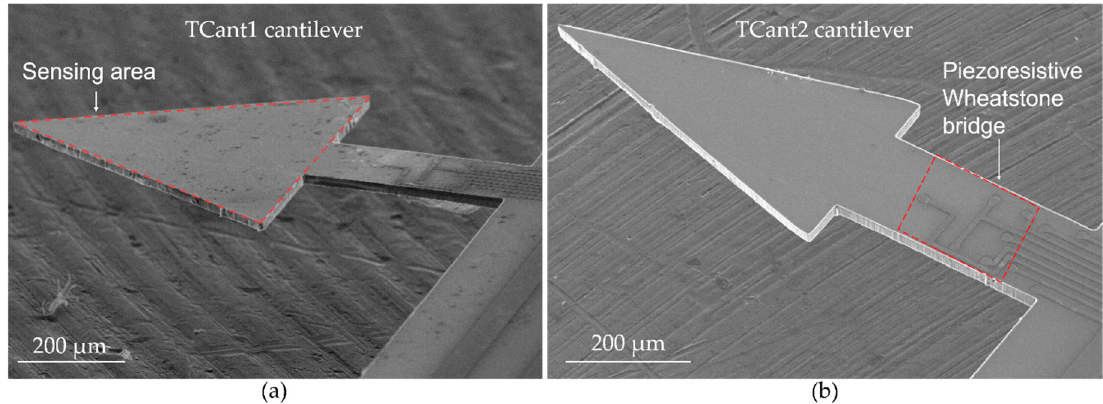
Figure 4. SEM images of silicon-based piezoresistive cantilever sensors after fabrication and basic cleaning processes, with ( a , b ) depicting TCant1 and TCant2 triangular cantilever cleaning processes, with ( a ) and ( b ) depicting TCant1 and TCant2 triangular cantilever sensors.